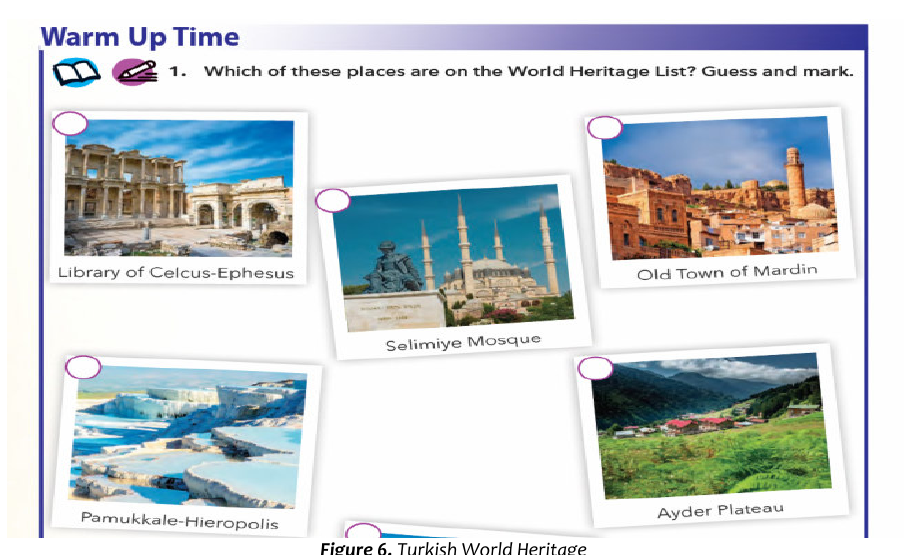
Figure 6. Turkish World